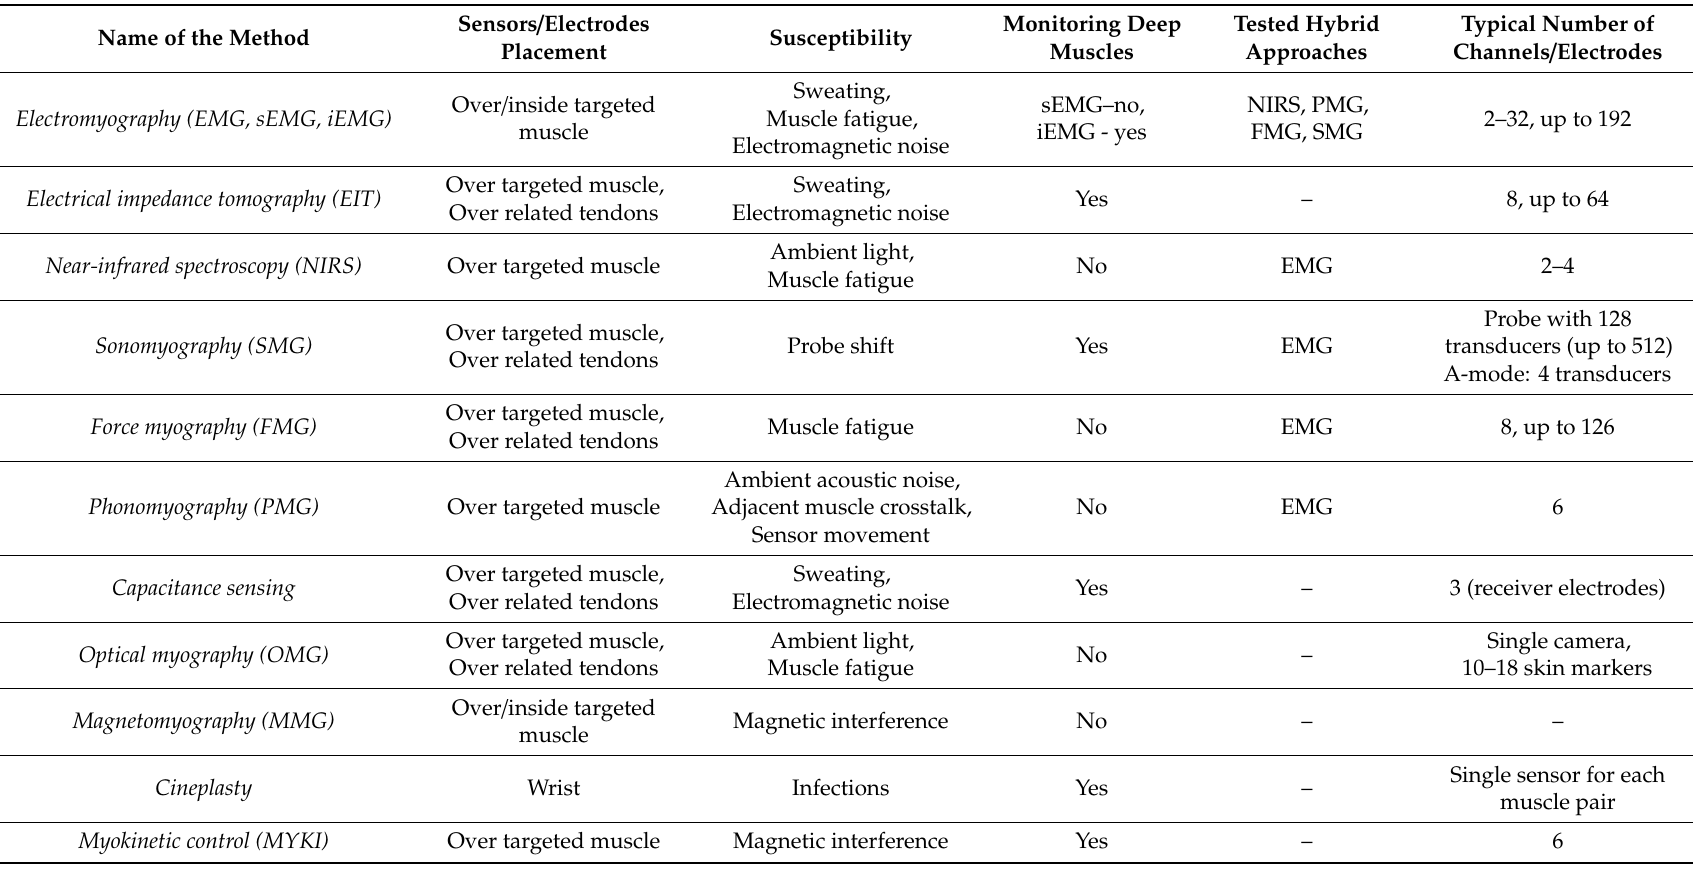
Table 2. Comparative overview of the control methods